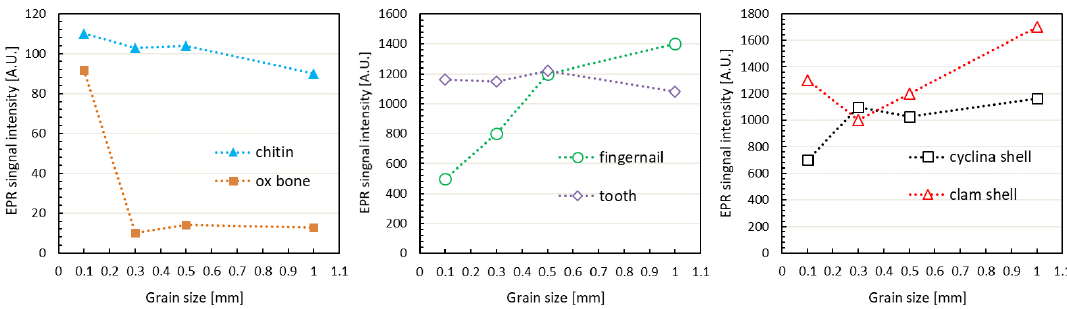
Figure 4. Dose response curve of different grain size for the six biological samples.